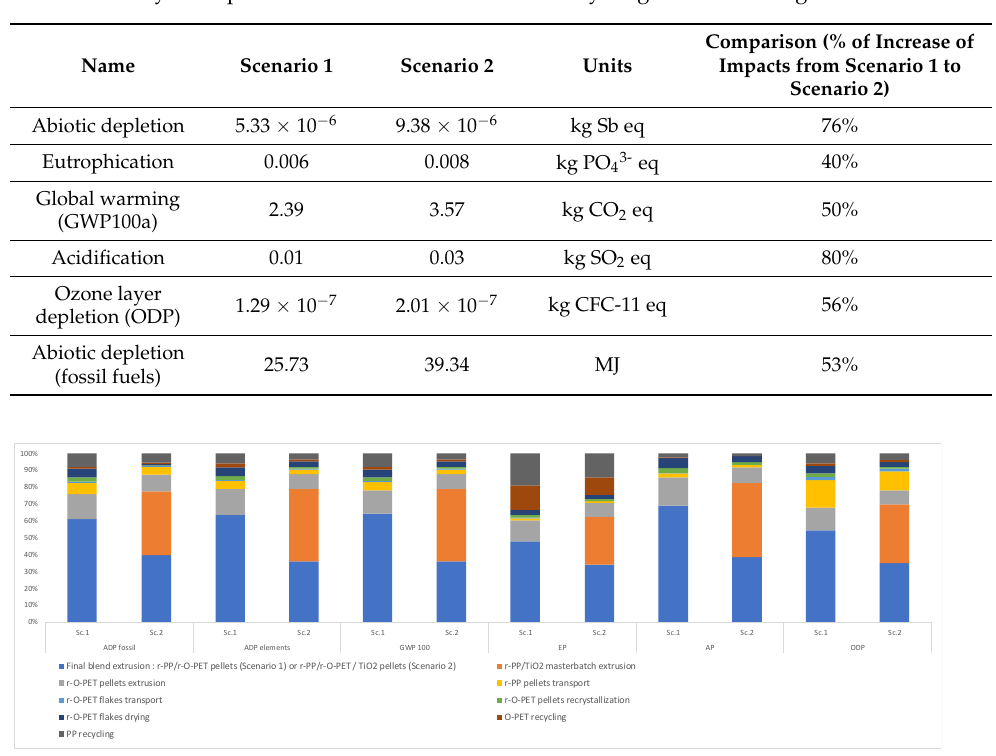
Figure 2. Contribution of the life cycle stages of the treatment processes to the environmental impact categories according to the CML method for both recycling scenarios.